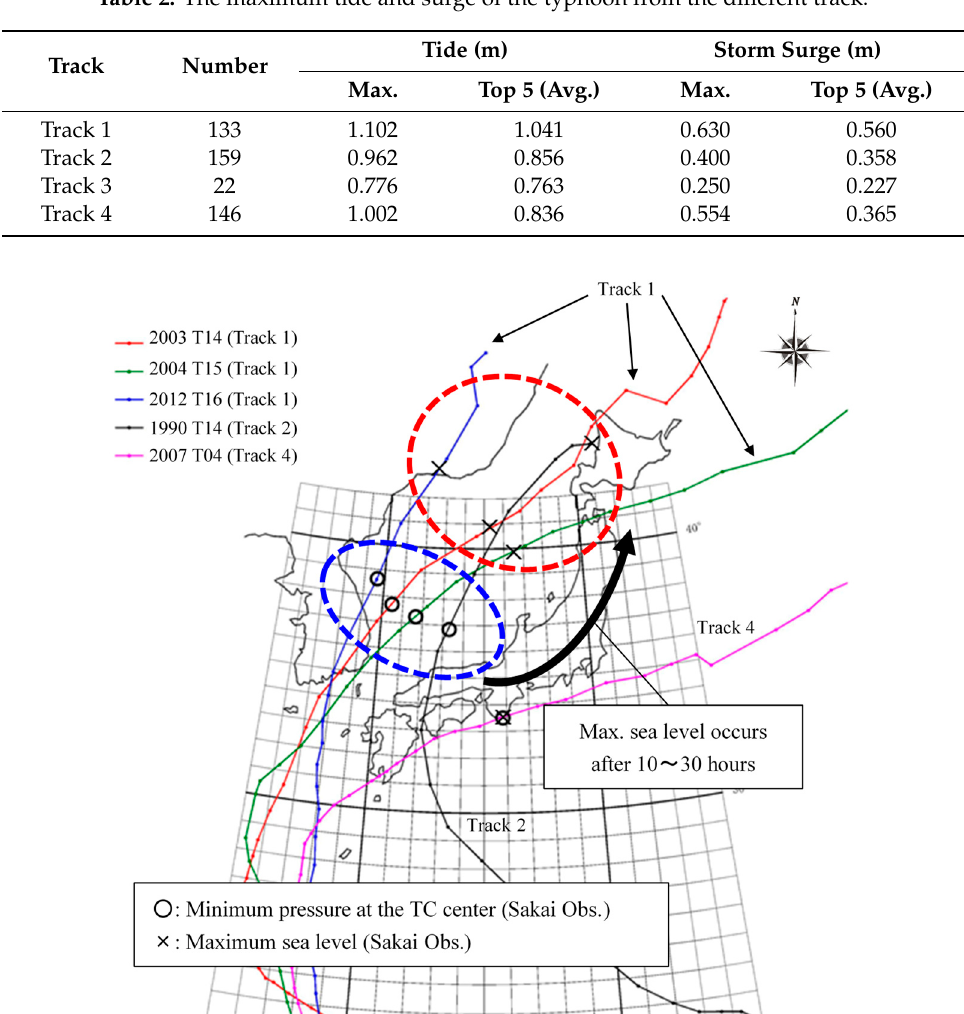
Figure 3. The results of five selected typhoons and characteristics of sea level based on observed data at Sakai